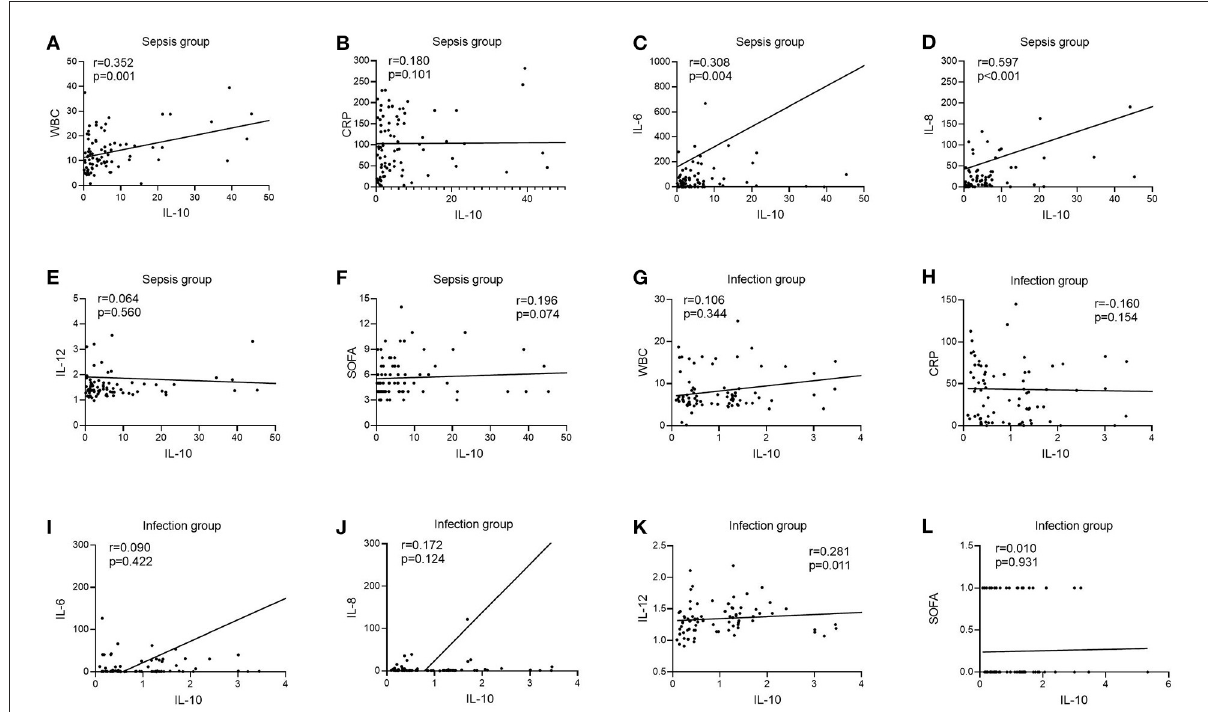
FIGURE3 Correlation of IL-10 with WBC, CRP, IL-6, IL-8, IL-12, and SOFA scores in patients in the infection and sepsis groups. (A) Correlation of IL-10 with WBC in patients in the sepsis groups; (B) Correlation of IL-10 with CRP in patients in the sepsis groups; (C) Correlation of IL-10 with IL-6 in patients in the sepsis groups; (D) Correlation of IL-10 with IL-8 in patients in the sepsis groups; (E) Correlation of IL-10 with IL-12 in patients in the sepsis groups; (F) Correlation of IL-10 with SOFA scores in patients in the sepsis groups; (G) Correlation of IL-10 with WBC in patients in the infection groups; (H) Correlation of IL-10 with CRP in patients in the infection groups; (I) Correlation of IL-10 with IL-6 in patients in the infection groups; (J) Correlation of IL-10 with IL-8 in patients in the infection groups; (K) Correlation of IL-10 with IL-12 in patients in the infection groups; (L) Correlation of IL-10 with SOFA scores in patients in the infection